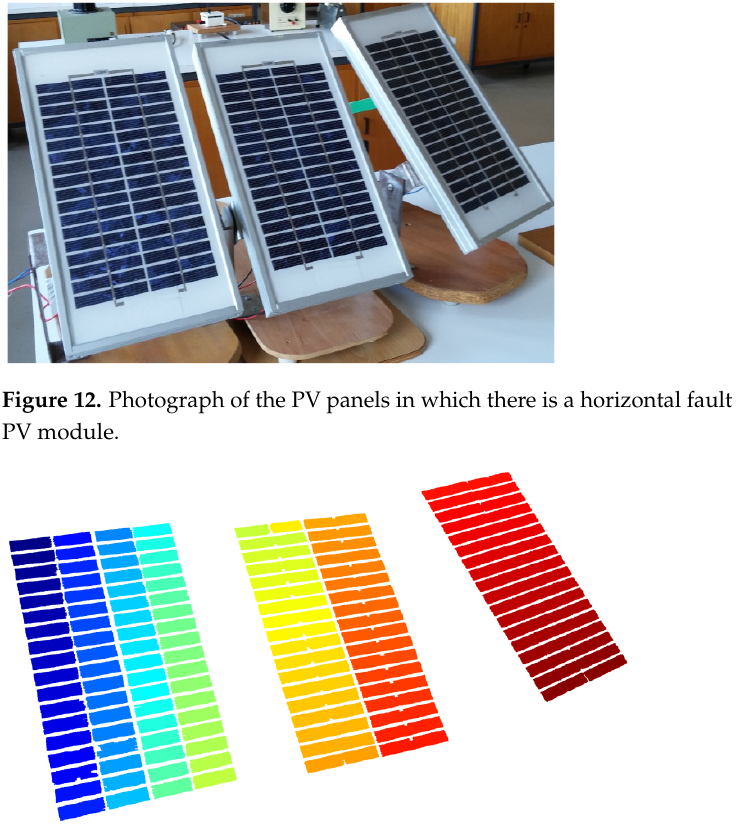
Figure 13. Isolation of the PV panels by image treatment (situation in which there is a horizontal fault in the tracker of the right PV module).